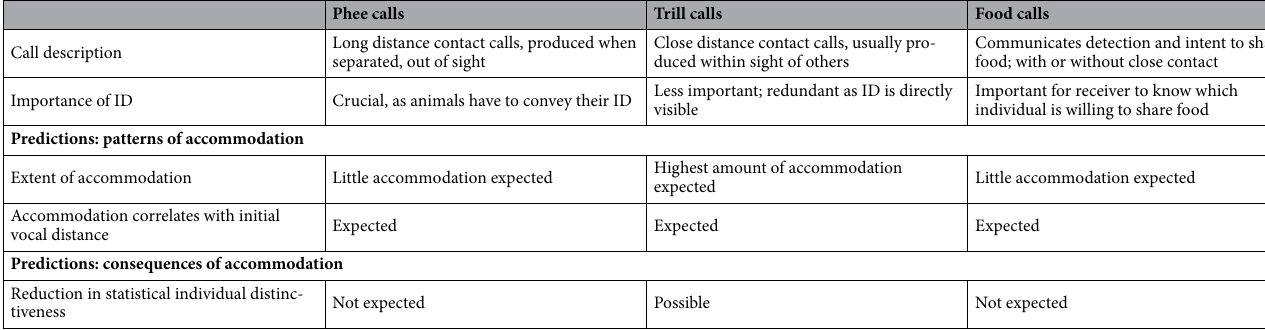
Table 1. Overview of the predictions: the table provides a short description of the three call types and how important transmitting identity (ID) is for each of them, and the predictions with regard to the patterns and consequences of